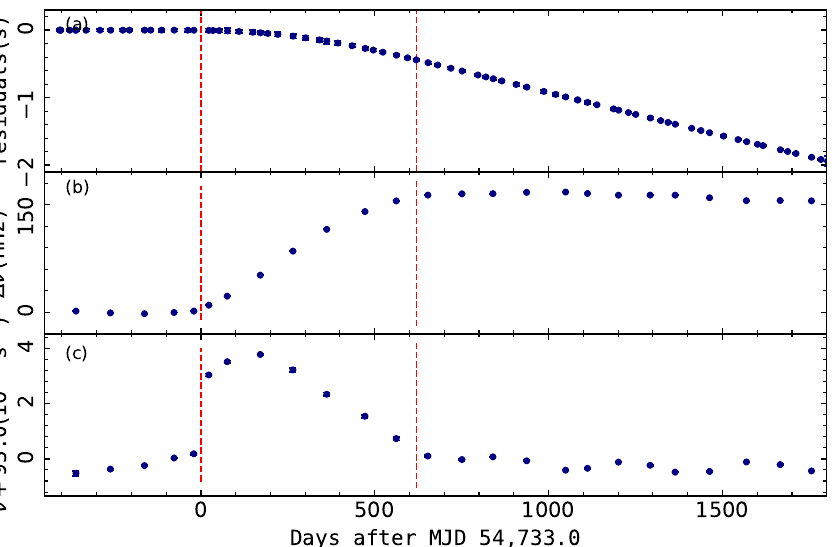
Figure 5. A very large slow glitch in PSR J1062–5100 [102]: ( a ) timing residiuals with respect to the pre-glitch spin-down solution; ( b ) variations of the frequency residual ∆ ν after subtracting the pre-glitch spin-down model. ( c ) observed variations of ˙ ν . The two red dashed vertical lines indicate that the slow glitch occurred between MJD 54,733 and